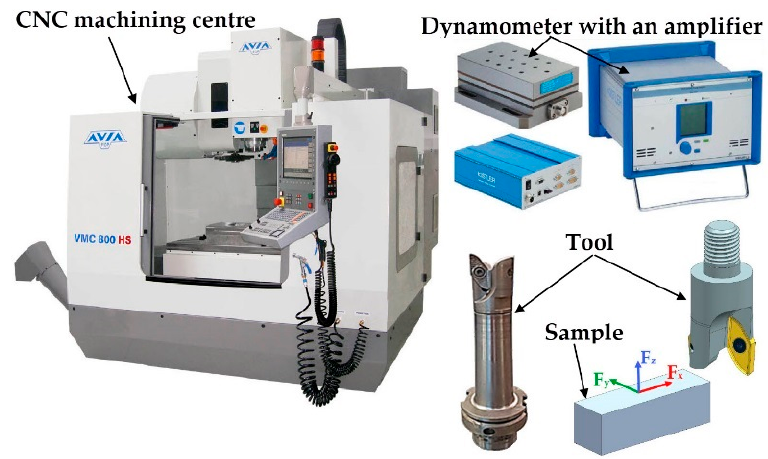
Figure 2. Schematic diagram of the methodology.